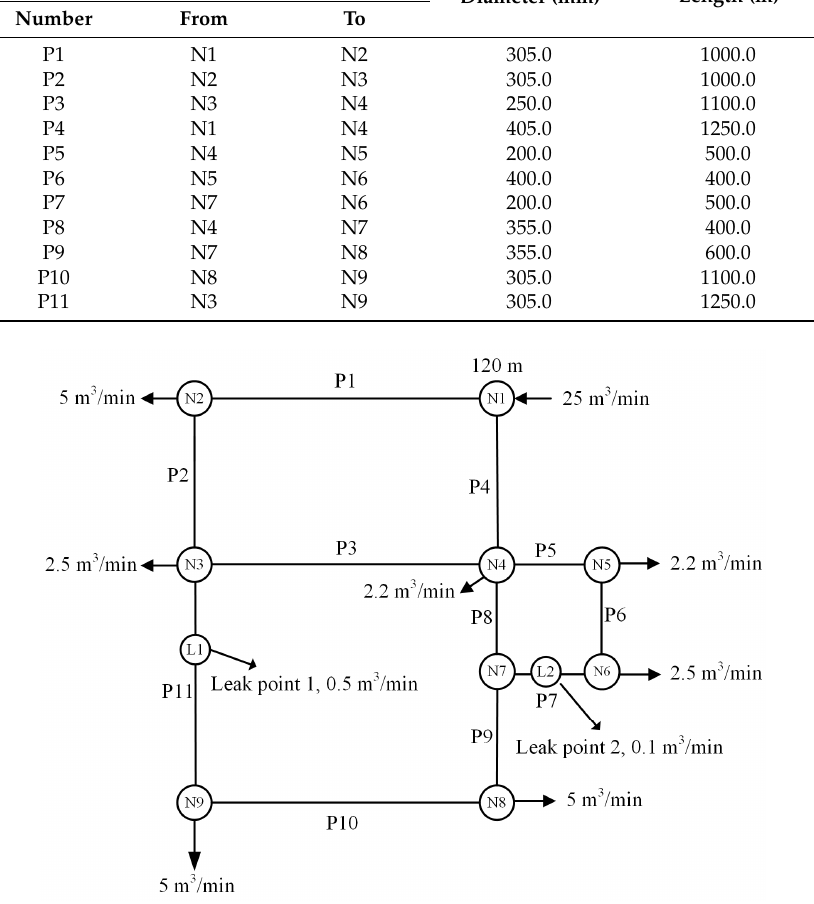
Figure 6. Configuration of synthetic pipe network B.